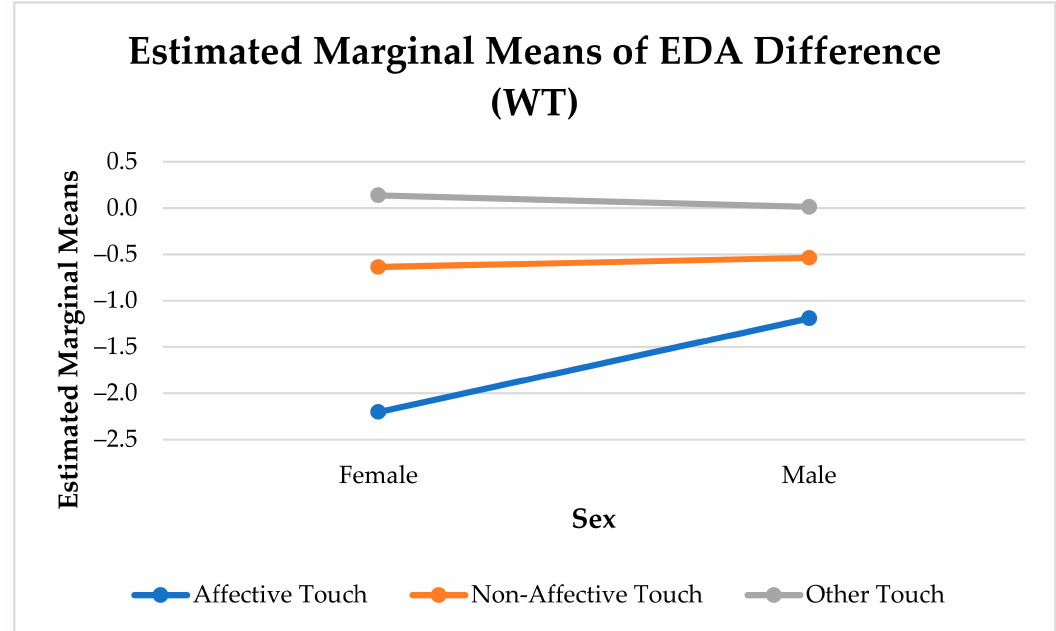
Figure 5. Sex Differences in Physiological Arousal Change Elicited by Touch.